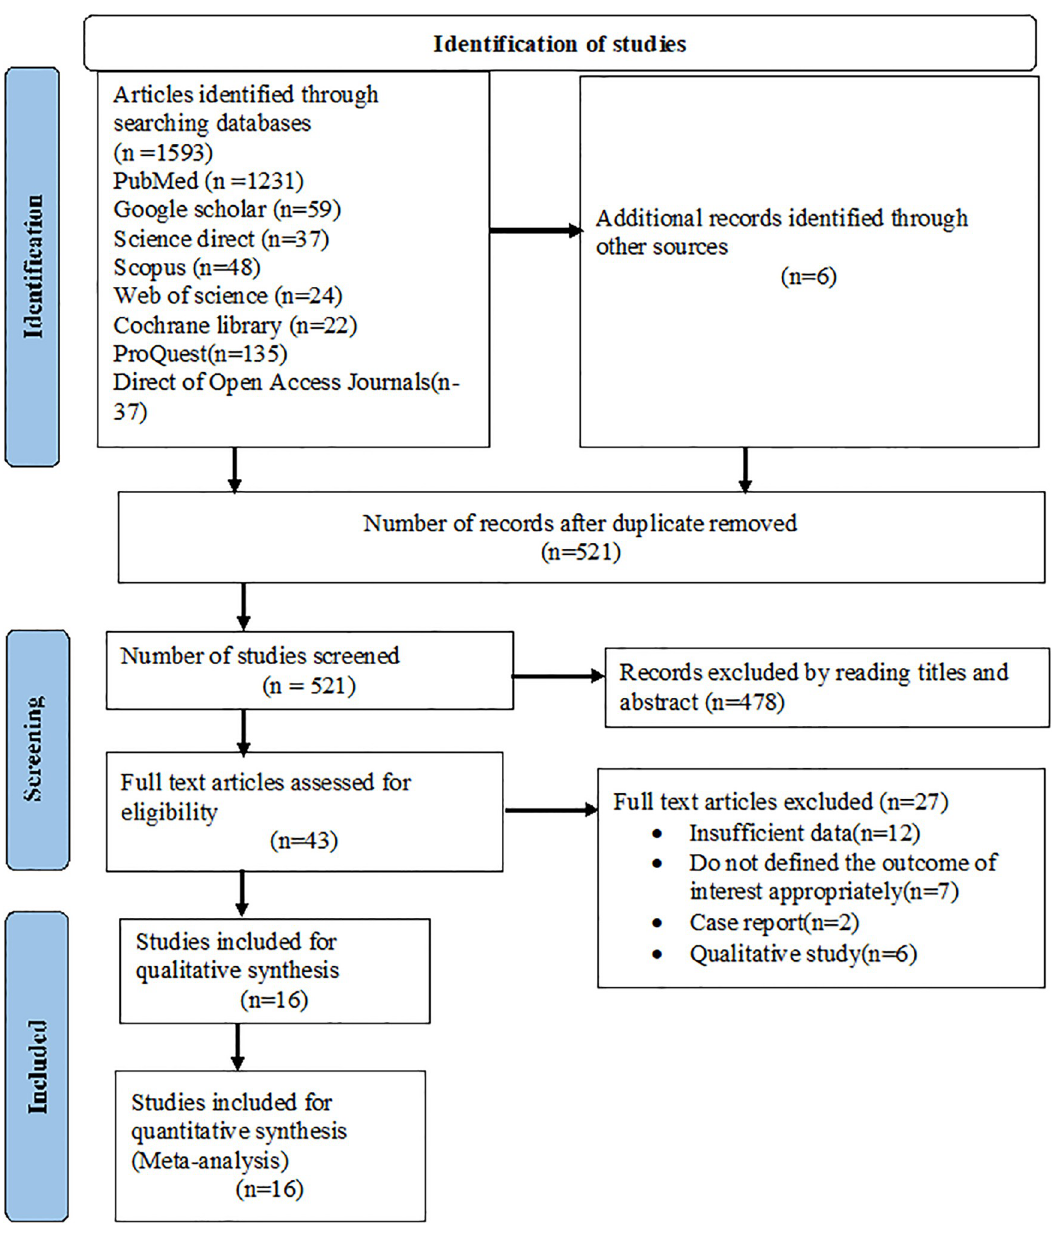
Fig 1. PRISMA flow diagram describing the selection of studies for systematic review and